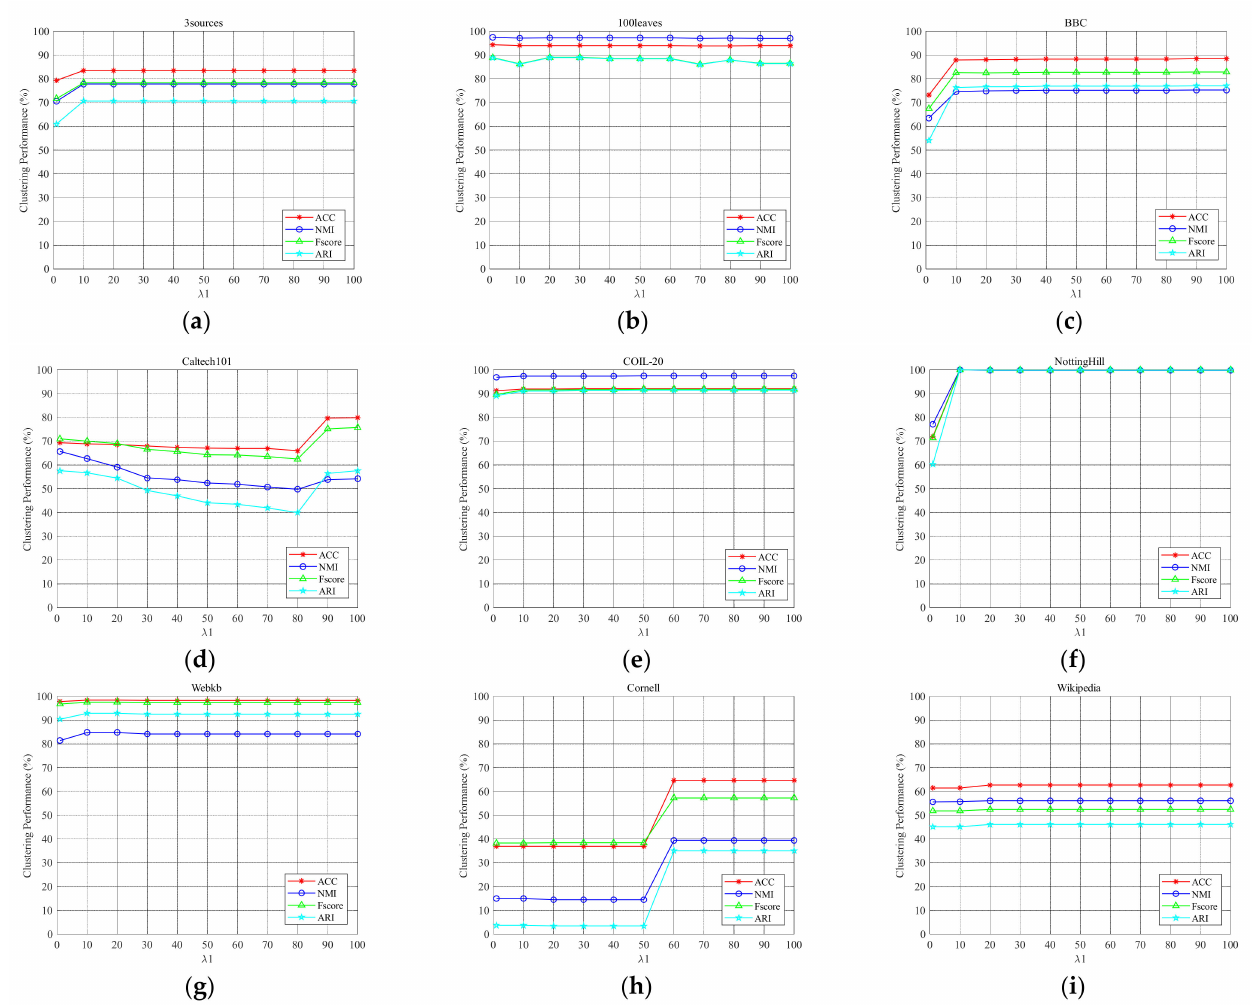
Figure 6. The parameter sensitivity of λ 1 on nine multi-view data sets. ( a ) 3sources, ( b ) 100leaves, ( c ) BBC, ( d ) Caltech101, ( e ) COIL-20, ( f ) NottingHill, ( g ) Webkb, ( h ) Cornell, ( i )